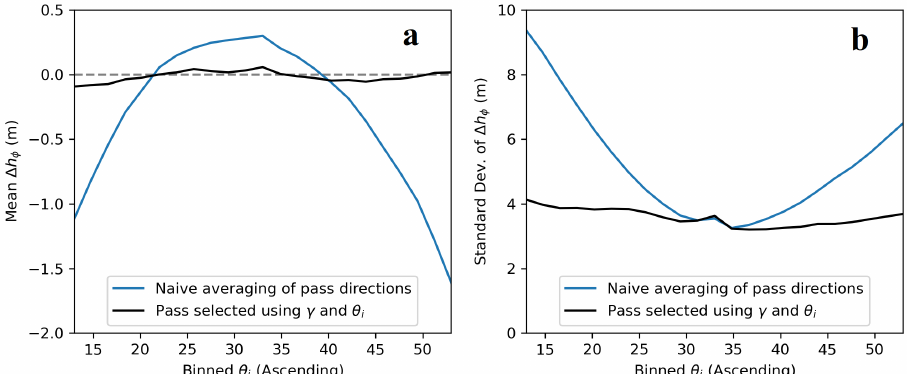
Figure 9. Statistics of ∆ h φ at the (3 × 3 multi-looked) TDX pixel level, binned by estimated local incidence angle for the ascending pass, which is essentially a proxy for terrain slope. Results obtained by averaging data from different pass directions (blue) is compared to results obtained by selecting pass direction at the pixel level (black). ( a ) Pass selection mitigates bias in the mean, and ( b ) reduces variance.